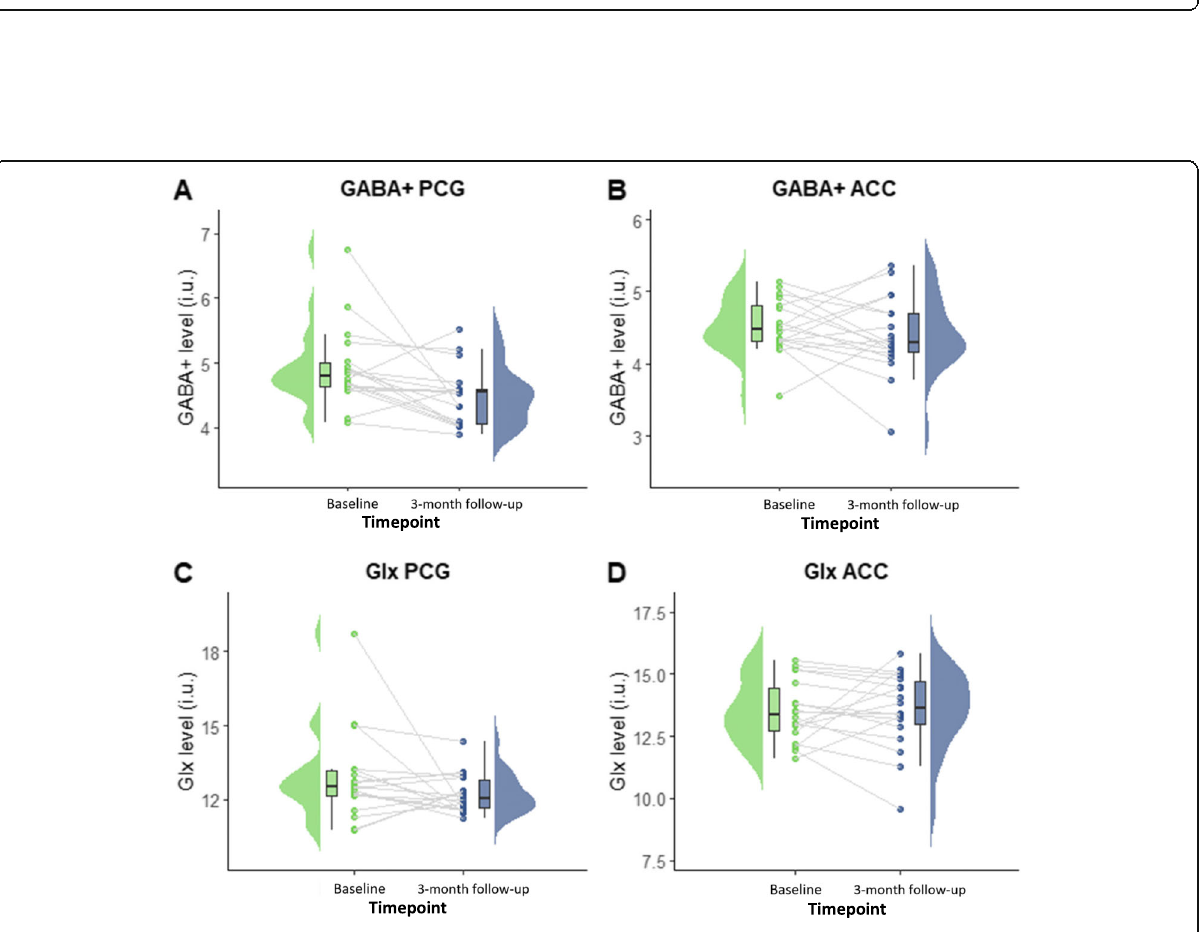
Fig. 3 Change in neurometabolite levels between timepoints for participants with migraine. GABA+ in A) PCG, B) ACC, and Glx in C) PCG and D) ACC. Each individual plot represents change in neurometabolite levels from baseline to 3-month follow-up in participants with migraine ( n = 18). Green data points represent neurometabolite levels at baseline and blue at 3-month follow-up. The grey lines represent change in individual participants neurometabolite levels over